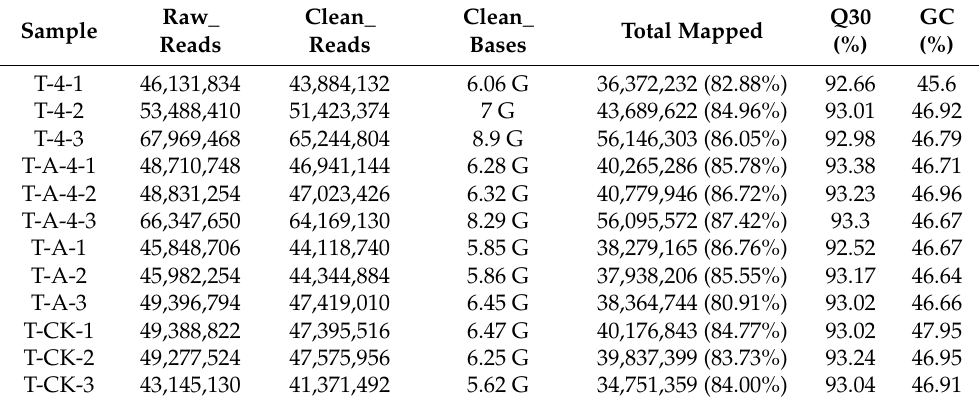
Table 3. Characteristics of transcriptome assembly under T-4, T-A and T-A-4 with T-CK treatments in tea